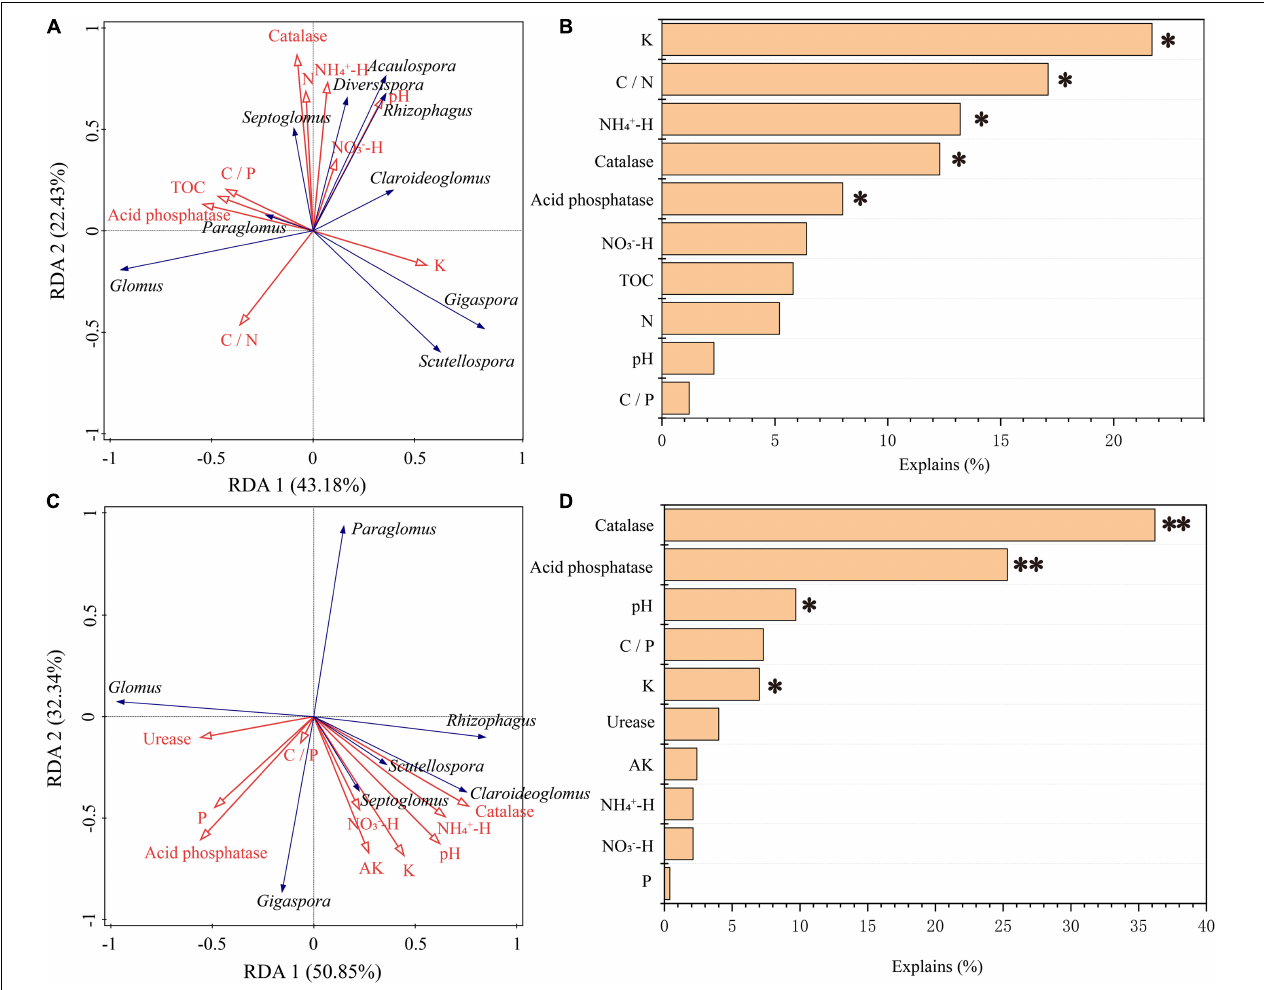
FIGURE 8 | Ordination plots of the redundancy analysis (RDA) showing the relationships between soil chemical properties (red arrows) and the AM fungal genera (blue arrows) in roots (C) and in the rhizosphere soils (A) . The contributions of soil chemical properties to the variations for AM fungal communities in the rhizosphere soil (B) and root (D) . ∗ p < 0.05, ∗∗ p < 0.01.